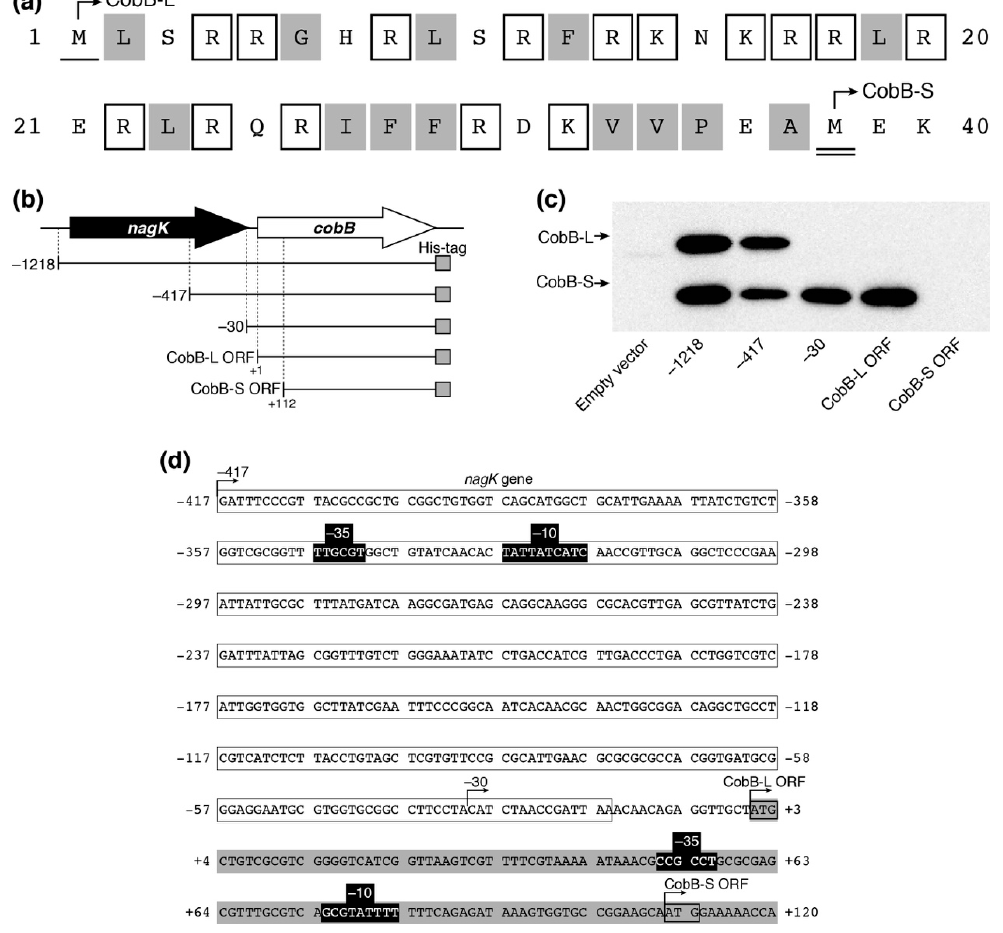
Figure 5. Expression of two CobB isoforms (CobB-L and CobB-S) in E. coli . ( a ) The primary sequence of N-terminal extension in CobB-L. The single and double underlines show the first methionine (Met) of CobB-L and CobB-S, respectively. The open and gray boxes indicate basic and hydrophobic amino acids, respectively (without Met). ( b ) Schematic representation of cobB -containing fragments in pACYC184P plasmid derivatives. ( c ) Expression of CobB isoforms in E. coli . Ten micrograms of lysate from E. coli DH10B harboring the pACYC184P derivatives was separated by 15% SDS-PAGE and analyzed by Western blotting using an anti-His-tag antibody to detect His-tagged CobB protein. ( d ) The nucleotide sequence of the cobB region. Open and gray boxes show the 3 ′ -region of nagK and 5 ′ -region of the cobB gene, respectively. The promoter containing − 10 and − 35 (black boxes) for CobB-L and CobB-S was predicted by BPROM of the Softberry web tool.